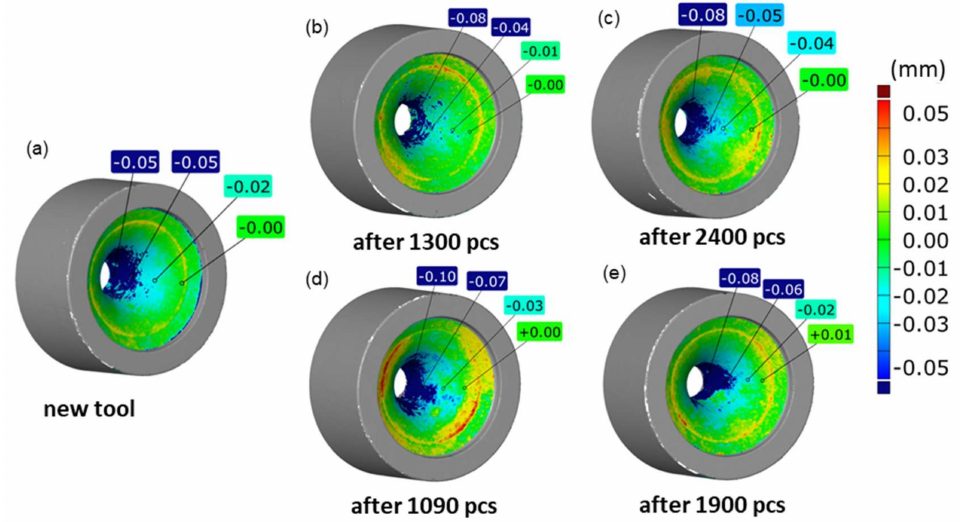
Figure 9. Comparison of the results of direct scanning of a die in relation to the scan of the replica from the dies (with standard setting of the angle, i.e., 55 ◦ ) for: ( a ) new tool, ( b ) tools with an ALWIN coating after 1300 forgings, ( c ) with an ALWIN coating after 2400 forgings, ( d ) with a BIGAN coating after 1090 forgings, ( e ) with a BIGAAN coating after 1900